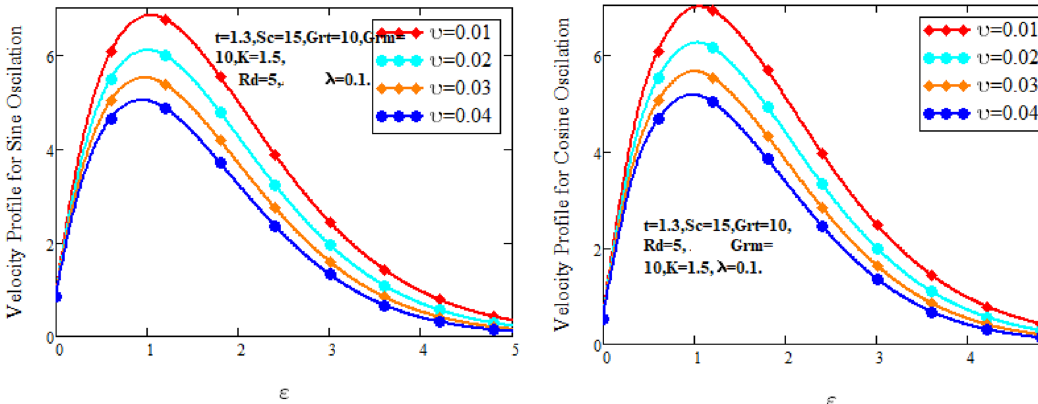
Figure 9. Velocity curves for various values of ϑ .